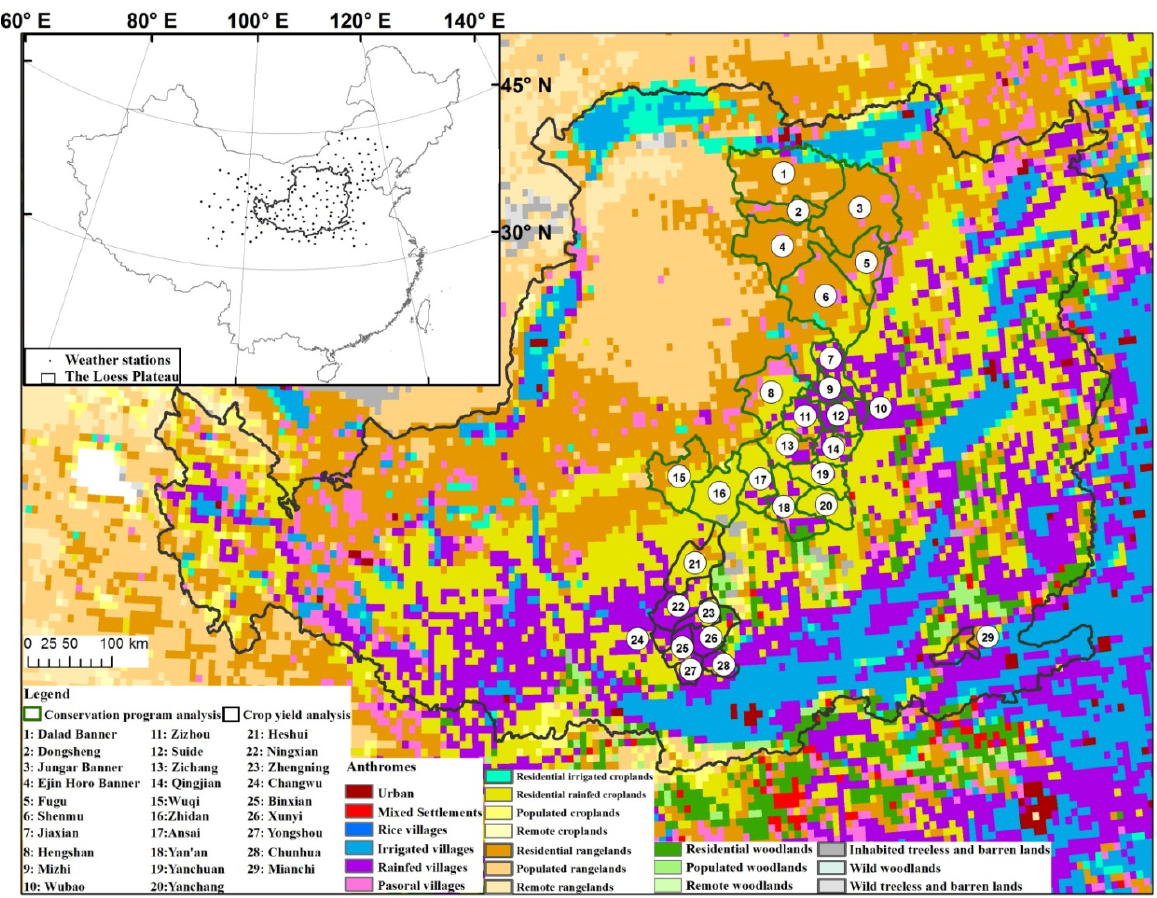
Figure 1. Upper left inset: Location of the Loess Plateau and the 138 weather stations in China. Main map frame: Location of key case study counties within the Loess Plateau. Case studies counties selected for conservation program analyses are outlined in green (County #1 to #20). Case studies counties selected for crop yield analyses are outlined in black (County #21 to #29). The spatial distribution of anthropogenic biomes is based on the anthropogenic biomes in 2000 as described in Ellis et al.